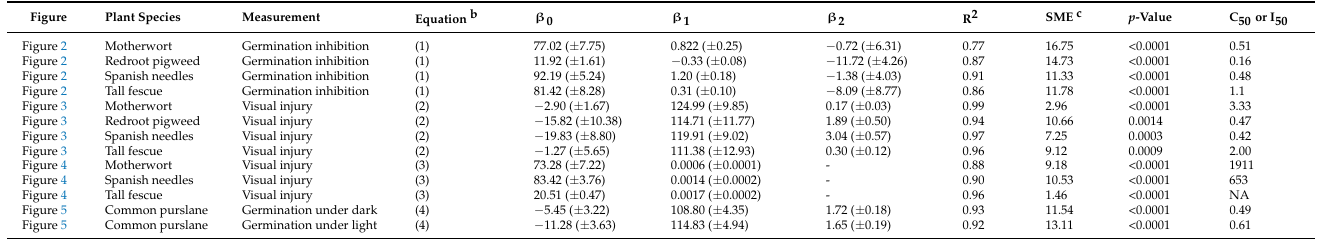
Figure 2. The impact of wood vinegar concentrations on the germination of motherwort, Spanish needles, redroot pigweed, and tall fescue. Vertical bars represent standard errors of the mean ( n = 8). Table 1. Regression parameters for data presented in figures a